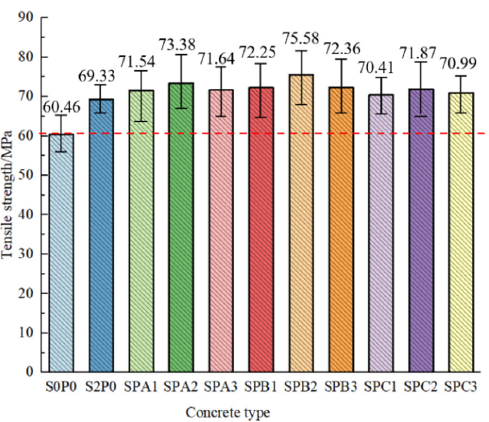
Figure 4. Compressive strength of concrete specimens in each group.